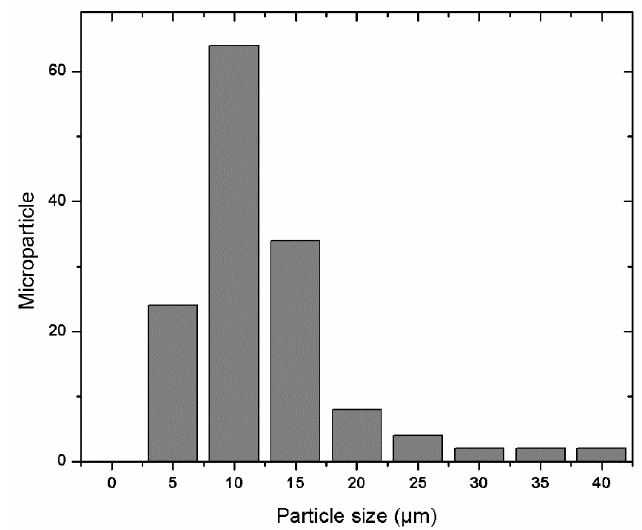
Figure 4. Microcapsule’s particle size distribution.